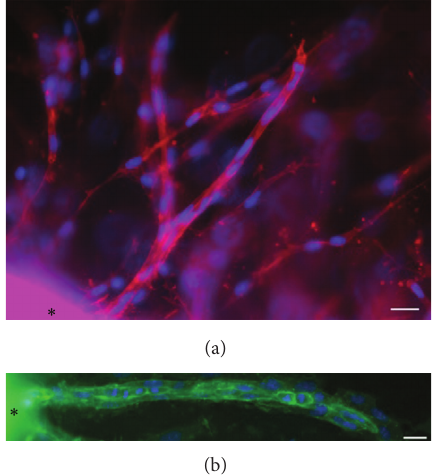
Figure 3: Rhodamine-phalloidin and lectin histochemistry. (a) After 11 days of cultivation, fluorescence microscopy showed cap- illary tubes that are stained with rhodamine-phalloidin for F-actin (purple-red) and 4 󸀠 ,6-diamidino-2-phenylindole (DAPI) nucleic acid stain (blue). The asterisk ( ∗ ) shows the mouse aortic explant. Scale bar = 20 𝜇 m. (b) After 11 days of cultivation, the capillary tubes are strongly positive for FITC-conjugated endothelial-cell-specific tomatolectinstaining(yellowish-green)andDAPInucleicacidstain (blue). The asterisk ( ∗ ) shows the aortic explant. Scale bar = 20 𝜇 m.